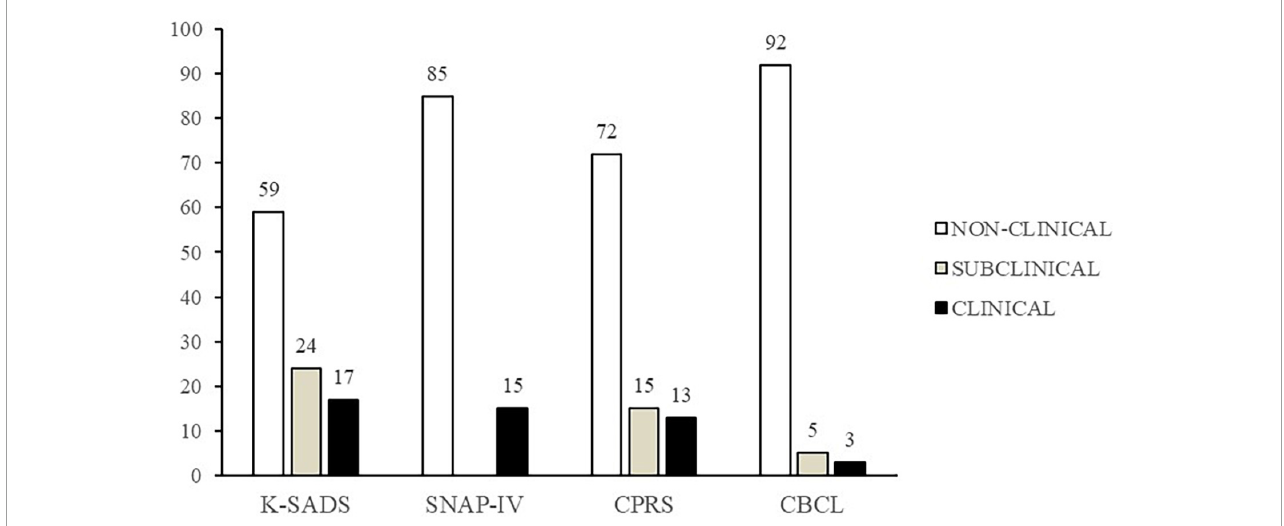
FIGURE1 Distribution of non-clinical, subclinical, and clinical scores as detected through Swanson, Nolan, and Pelham–IV Rating Scale (SNAP-IV), Conners’ Parent Rating Scales Long Version (CPRS), Child Behavior Checklist (CBCL), and Schedule for Affective Disorders and Schizophrenia for School Aged Children Present and Lifetime (K-SADS) (%).